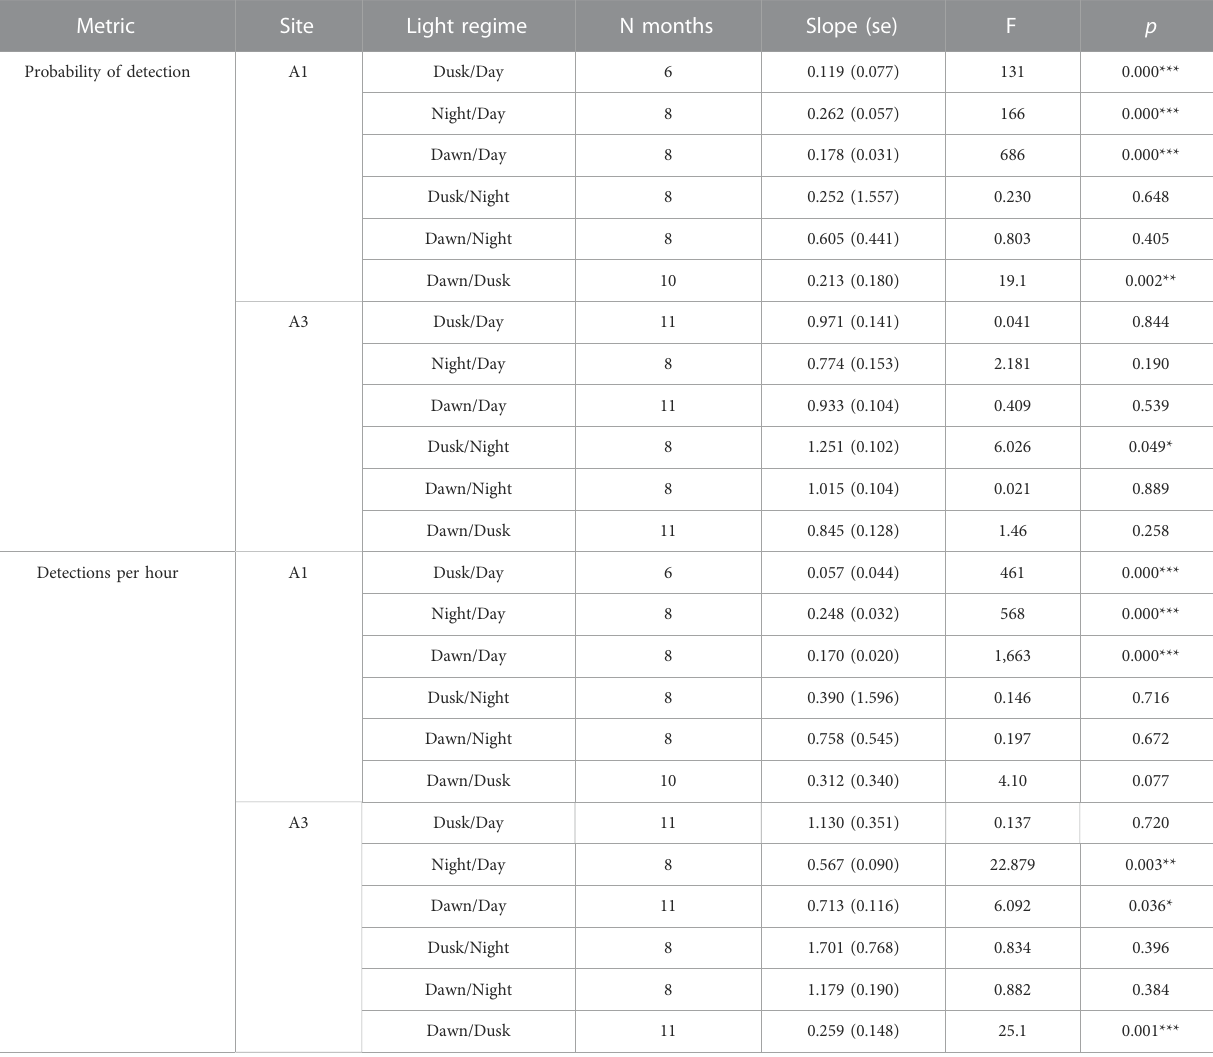
TABLE 5 Effect of time of day on mean probability of detecting sperm whale in a given hour and mean detection rate ( “ detections per hour ” ) as described in the text. “ Light regime ” gives the comparison between the monthly detection in one period to that in another (see Methods for de fi nitions of periods). “ N months ” : Numberofmonthcomparisonspossible. Nocomparisonsarepossibleifthereisnodataorzerodetectionsineitherperiod. “ Slope ” :Fittedslopeofregressionline (akin to adds ratio, Figure 9). “ F ” : F-value for null hypothesis that the slope = 1 (i.e., no effect of time on day on detection). “ P ” : Probability associated with F-test, signi fi cance: < 0.001***; < 0.01**; <